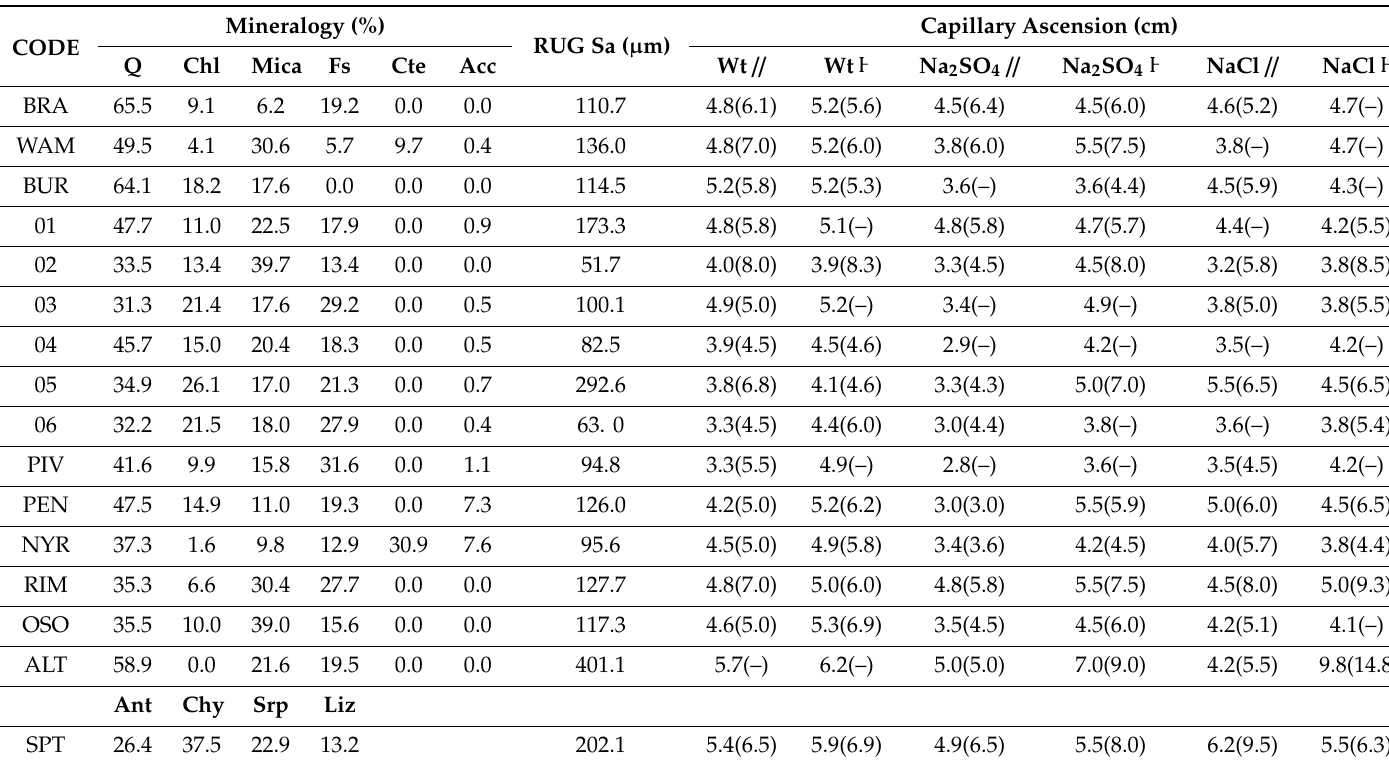
Table 2. Results for the determination of roughness (RUG), capillary ascension, and mineralogy. Mineral abbreviations are Q: Quartz, Chl: Chlorites, Fs: Feldspars, Cte: Carbonates, Acc: Accessory minerals, Ant: Antigorite, Chy: Chrysotile, Srp: Serpentinite, and Liz: Lizardite. Directions parallel and perpendicular to L 0 are indicated as // and Ͱ , respectively. Wt indicates water capillary ascension in cm. Values in parentheses in the capillary results refer to the maximum height reached, as in Figure 7C–D.